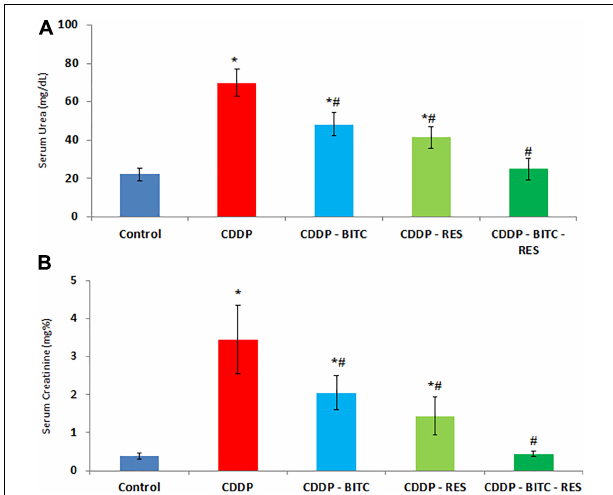
FIGURE 3 | The effects of RES and BITC treatment on serum concentrations of (A) urea and (B) creatinine in cisplatin-intoxicated mice. Data are means ± standard deviations. CDDP, cisplatin. ∗ Significantly different from the normal control group at p < 0.05. # Significantly different from the CDDP group at p <